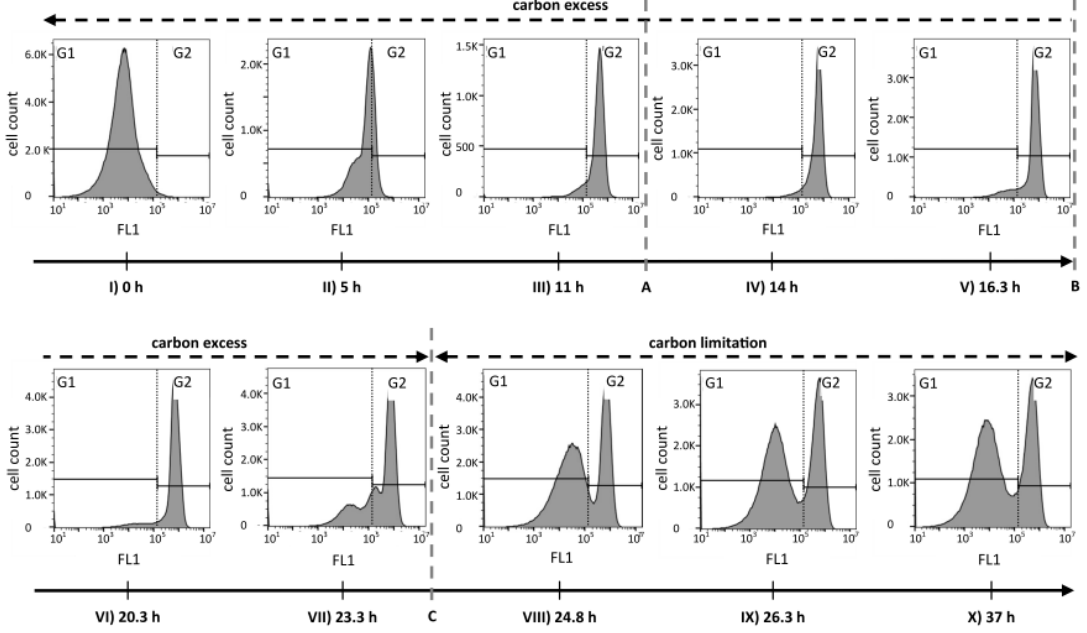
Figure 3. Histograms of fluorescence data (FL1) representing the PHA distribution among P. putida KT2440 cells during a fed-batch with a phase of carbon excess and a phase of carbon limitation. The green fluorescence of BODIPY 493/503 stained cells was recorded by flow cytometry during the bioprocess that is depicted in Figure 1. The dashed lines A, B, and C correspond to the time points ( A ) 12.3 h feed changed from exponential to linear mode; ( B ) 16.3 h the carbon feeding was stopped and an ammonium pulse was added; and ( C ) 24 h the carbon source was depleted. The gates G1 and G2 (black step lines and dotted vertical line) separate low and high FL1 values, respectively, and were defined based on the histogram from PHA-free cells at the time of inoculation, to visualize the evolution of the FL1 signal.